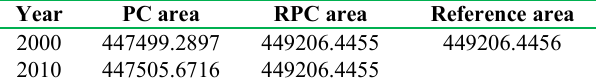
Table 2. Results of the test(km)